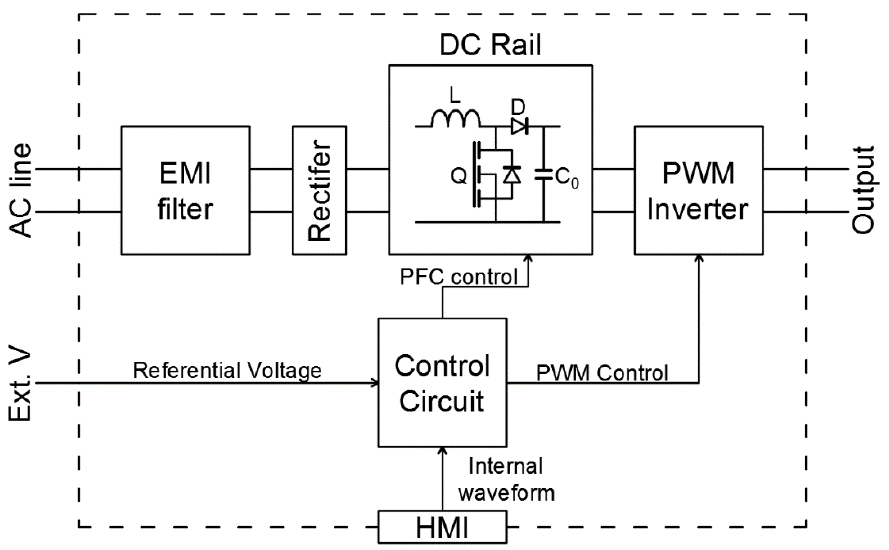
Figure 1. Block diagram of the pulse width modulation (PWM)-based wideband power source.